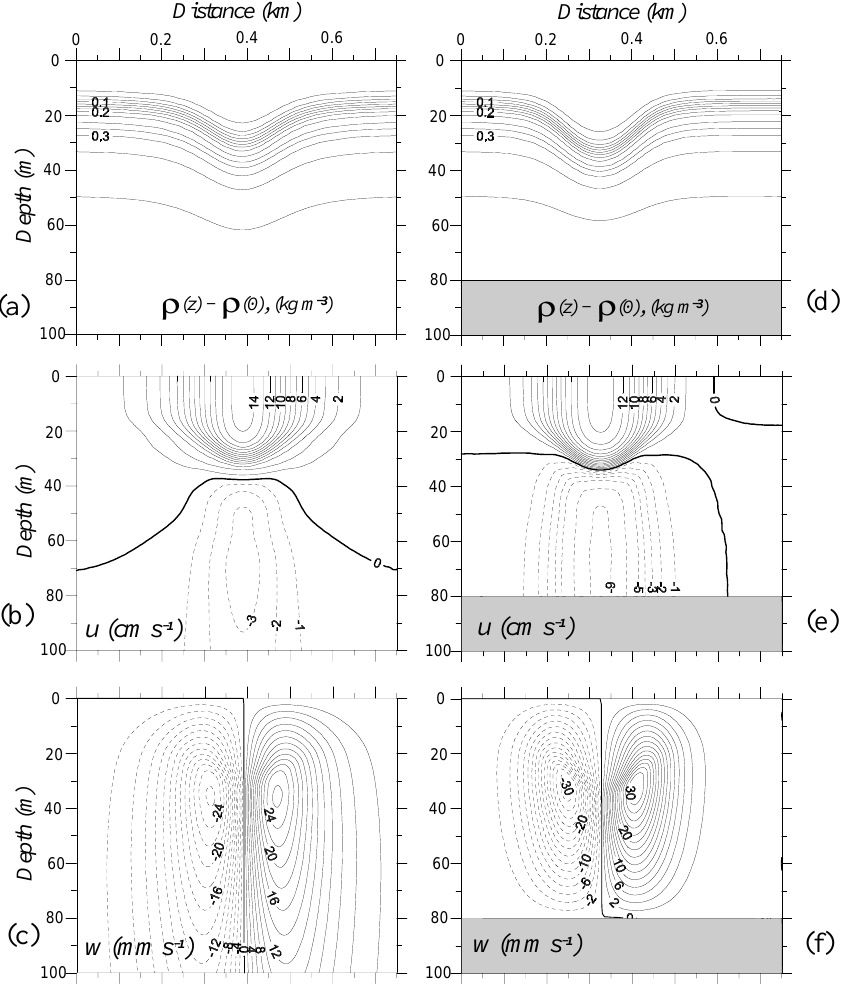
Fig. 4. The left column represents the initial solitary wave with amplitude a m = 15m in the deep part of the lake with depth of 200m. The right column displays the results of adjustment of the incident wave to the conditions of the shallower basin with depth of 80m. Panels (a) and (d) show the density anomaly relative to the free surface ( kg · m − 3 ), panels (b) and (e) show the fields of horizontal velocity u(cm · s − 1 ) , (c) and (f) those of the vertical velocity w(mm · s − 1 )